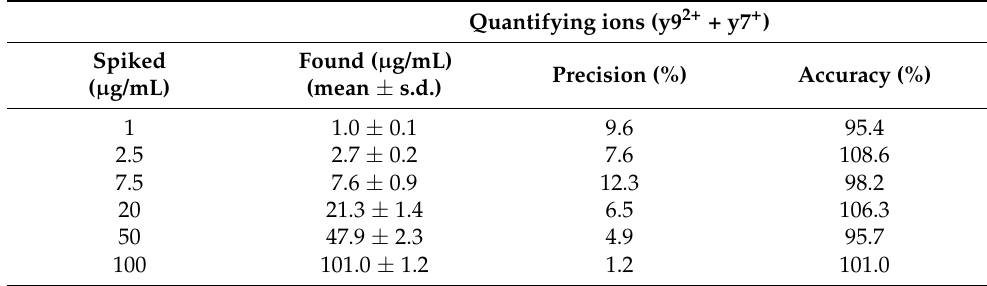
Table 2. Inter-day validation ( n = 5 days) for the determination of pembrolizumab in plasma ( n = 7).